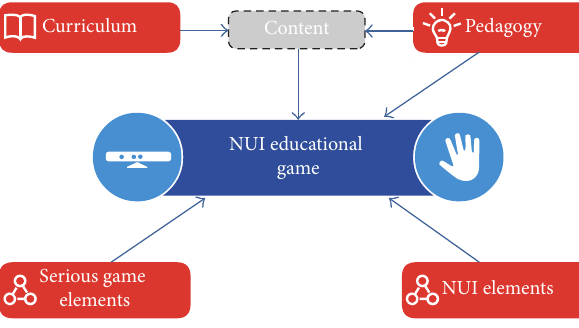
Figure 6: NUI educational games